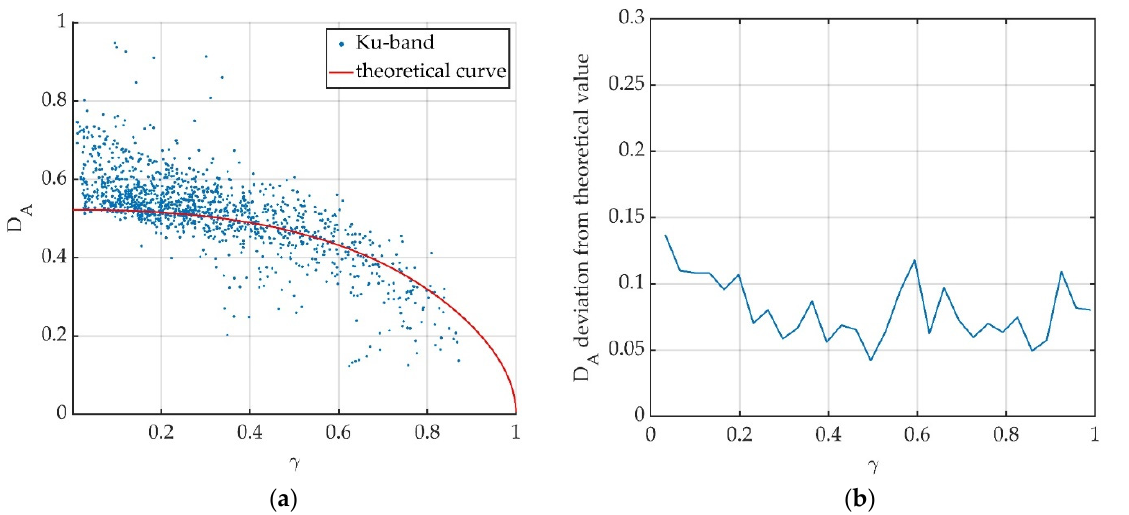
Figure 13. Results obtained for Ku-band data. ( a ) Values of D A as function of the coherence, calculated for resolution cells of the investigated area, in the urban scenario, in Florence. ( b ) Deviation of experimental D A values from theoretical